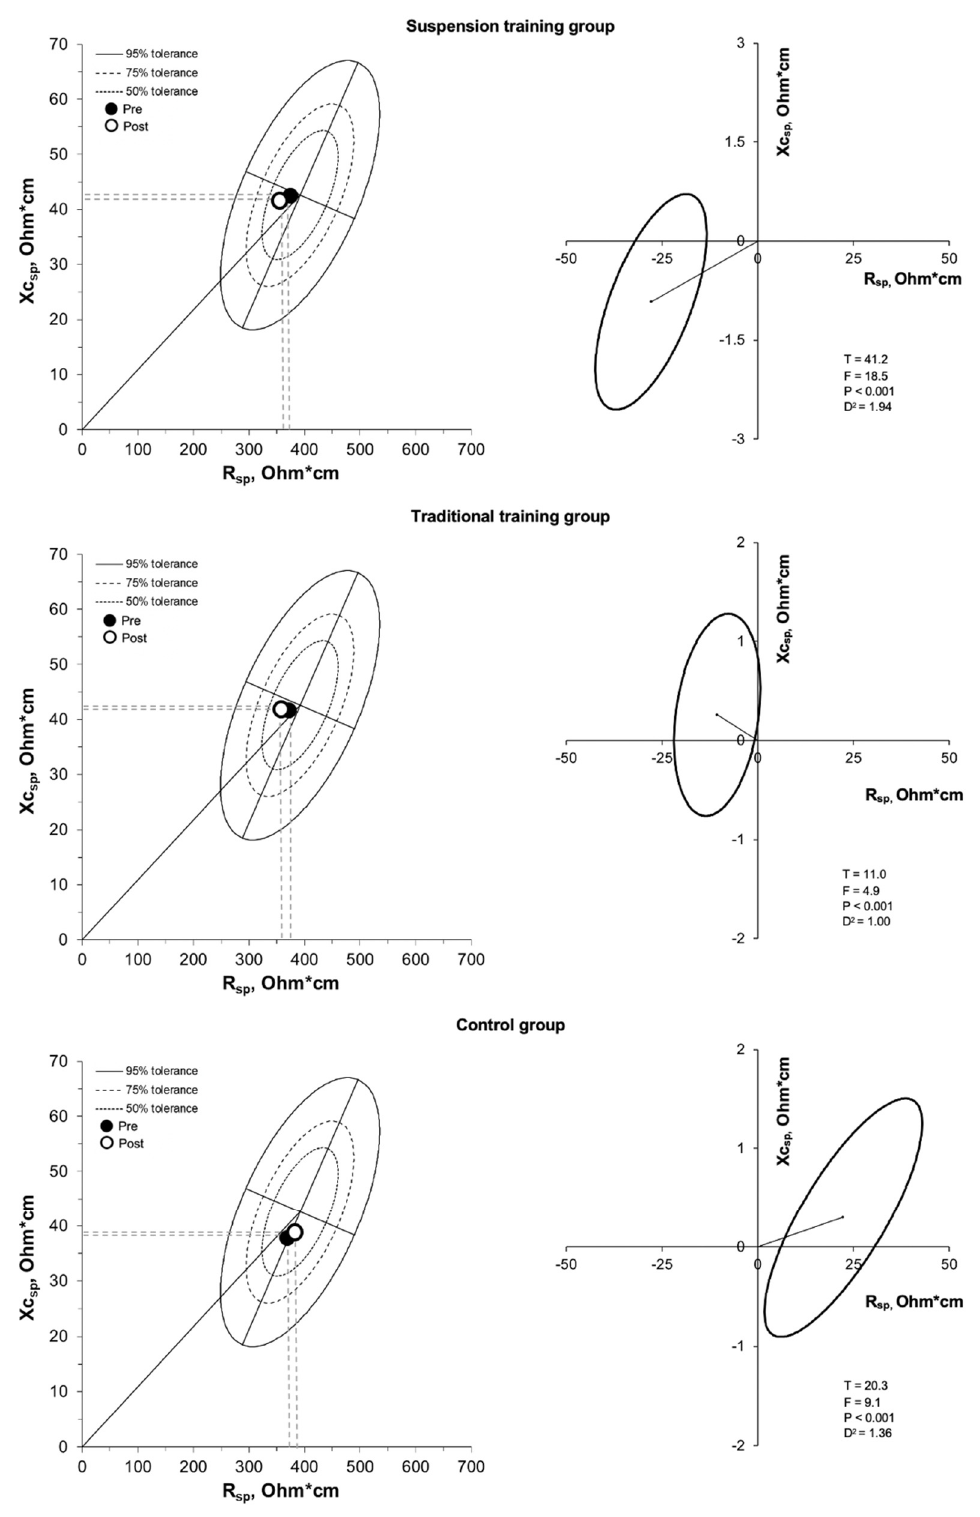
Figure 4. R-Xc and paired graphs for the multivariate changes in specific resistance and reactance are shown. On the left panels, bioimpedance data are plotted on the tolerance ellipses of the reference population. On the right panels, mean vector displacements with 95% confidence ellipses and results of the Hotelling’s T 2 test are shown.